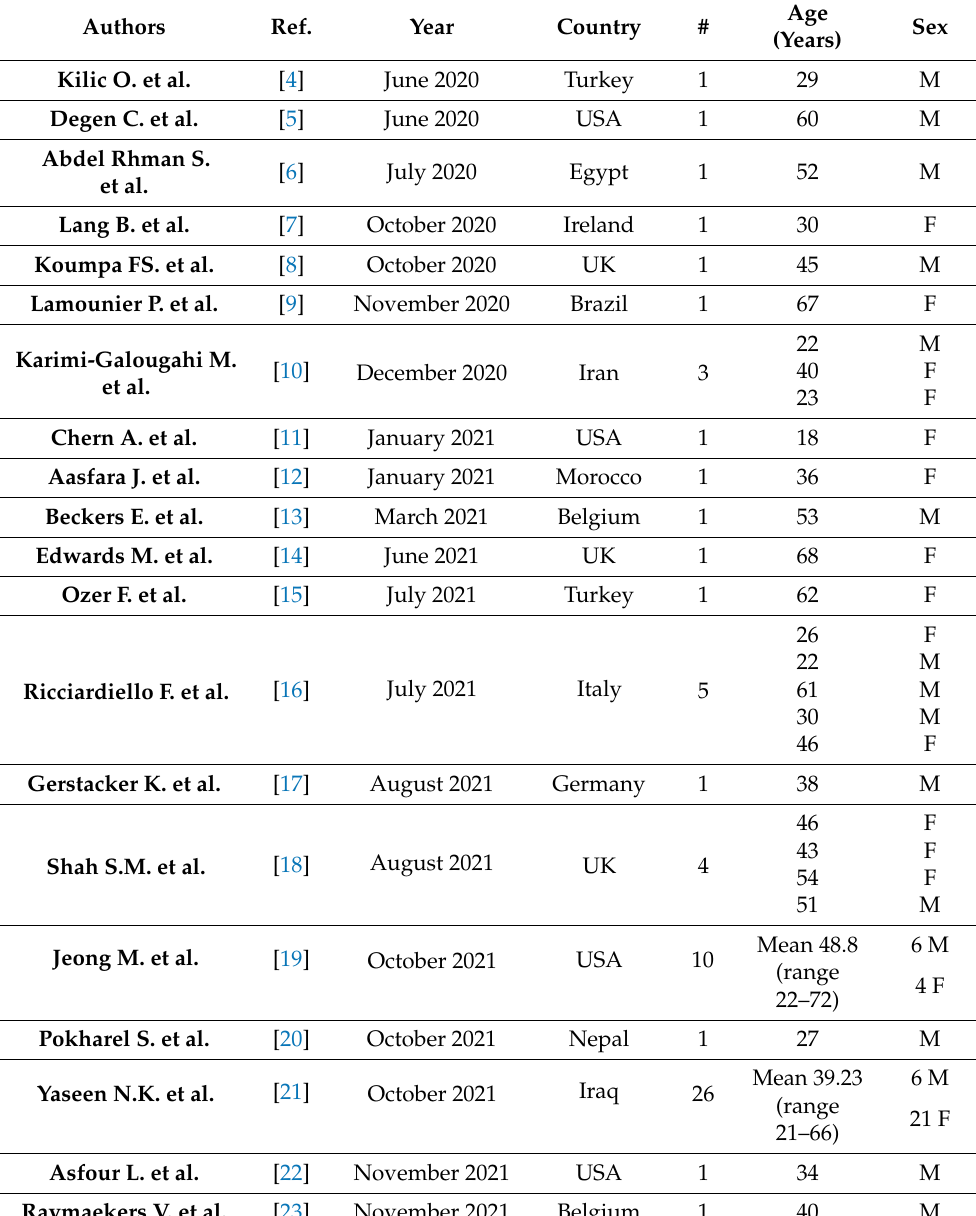
Table 1. List of papers reporting a new SNHL onset, post COVID-19 infection (Ref. = number of bibliographic references, # = number of